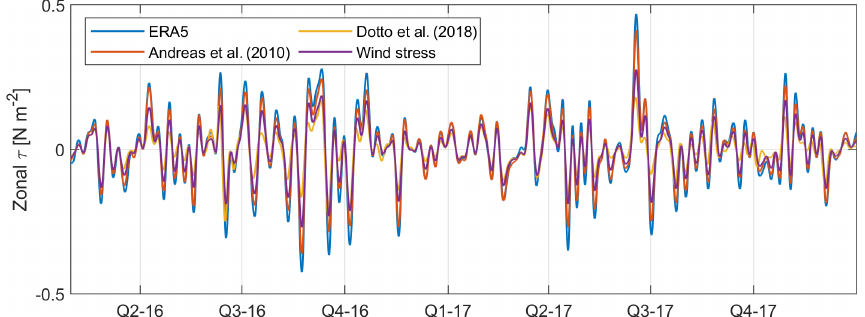
Figure B1. Different estimations of τ using the output from ERA 5 (blue), and explicit calculations using the parameterization of C d from Andreas et al. (2010) (red), parameterization of C d from Dotto et al. (2018) (yellow), and the wind stress without accounting for sea ice (purple). All time series are filtered with BP 8D–10M